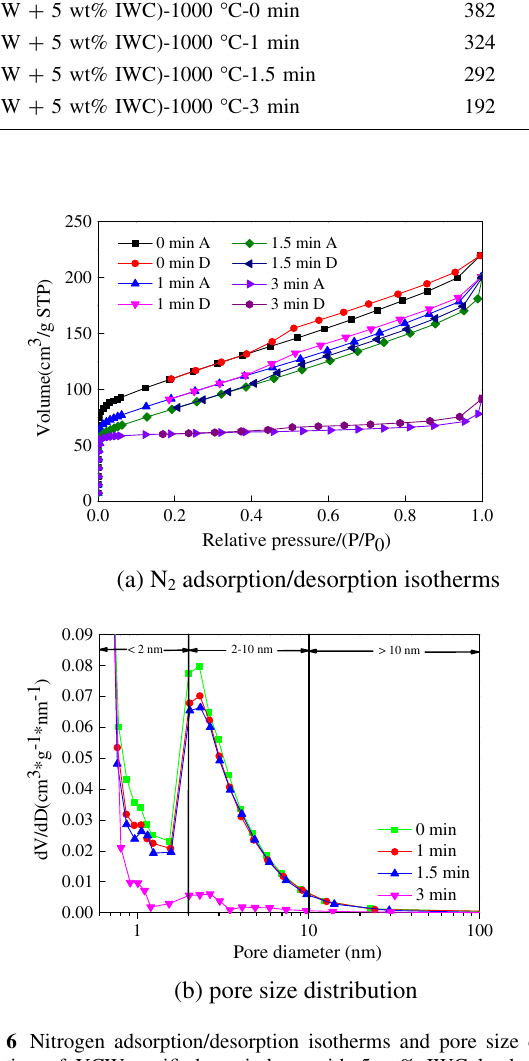
Fig. 6 Nitrogen adsorption/desorption isotherms and pore size dis- tribution of YCW gasified semi-chars with 5 wt% IWC loaded at 1000 (cid:3) C (A: adsorption isotherm; D: Desorption isotherm)